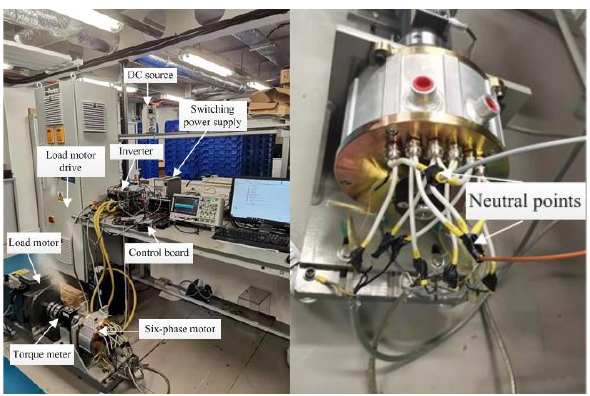
Figure 19. The experiment platform.